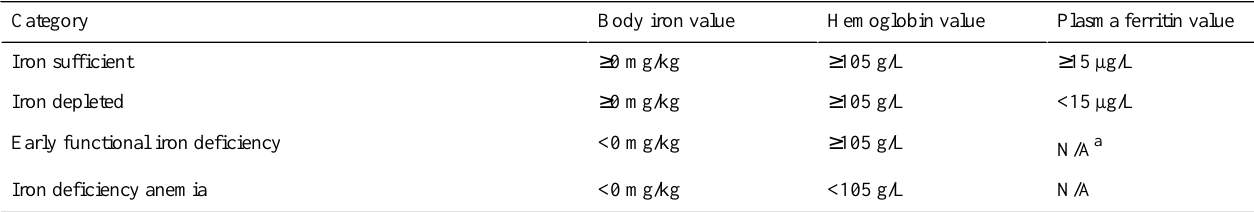
Table 1. Iron status